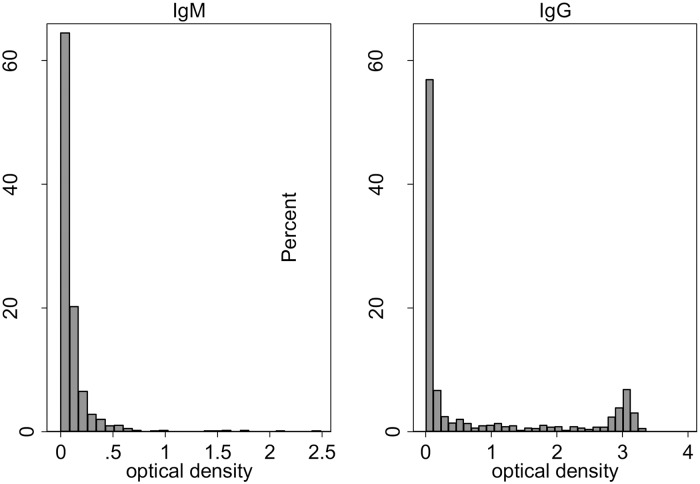
Optical densities for cases and controls, left panel IgM, right panel IgG.